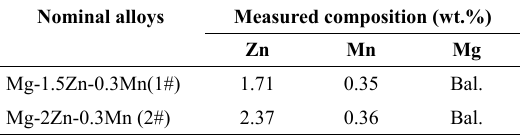
Table 1. Chemical compositions of the Mg alloy samples Nominal alloys Measured composition (wt.%)